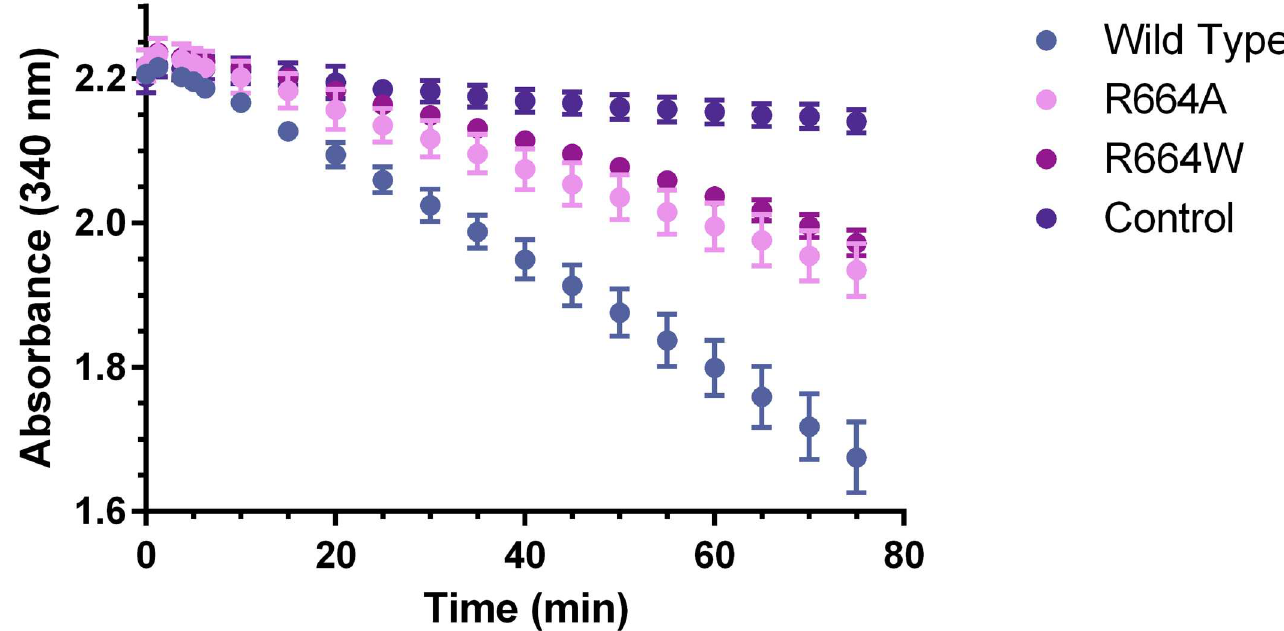
Fig 5. Kinetic assaysof FGFR2 kinase. Kinetic assays were performed for wild-typeFGFR2 kinase as well as R664Aand R664W mutants. The control assay was performed without the presenceof protein.